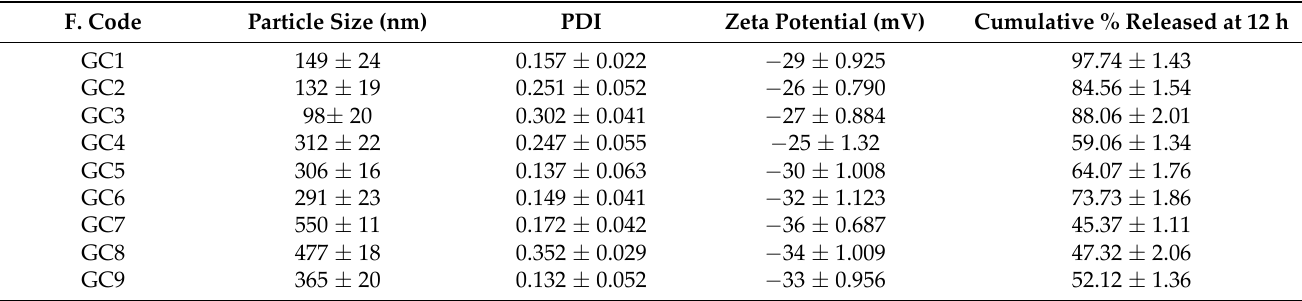
Table 2. Particle size, PDI, and zeta potential and cumulative % released at 12 h of GFT‑CNP formu‑ lations (values are represented as the mean ±